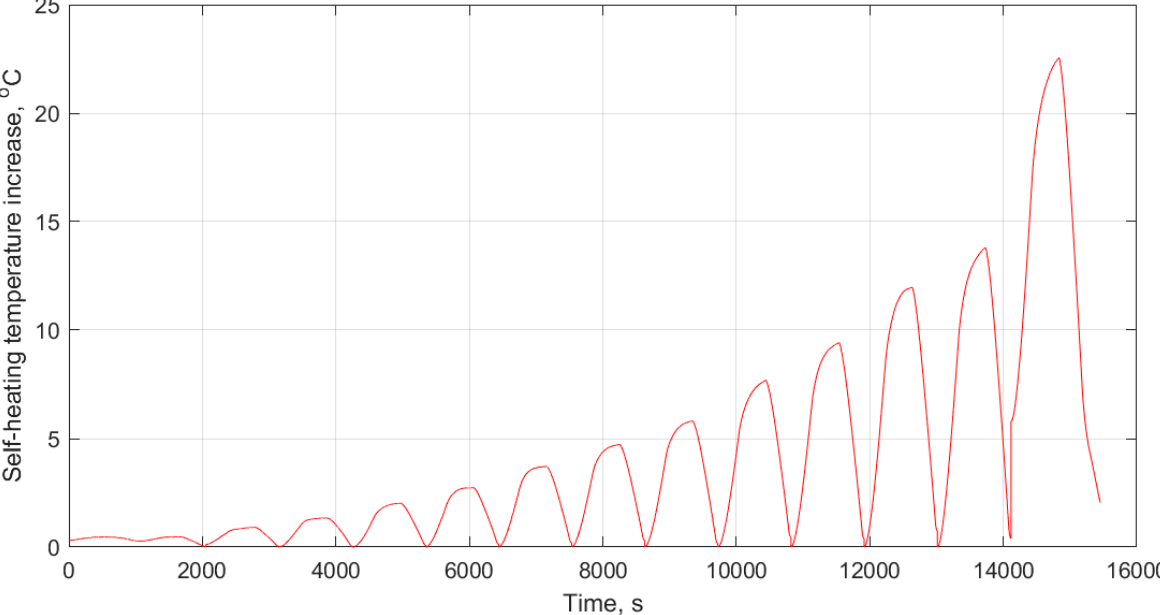
Figure 5. An exemplary illustration of self-generated heating temperature response for elevated loading.